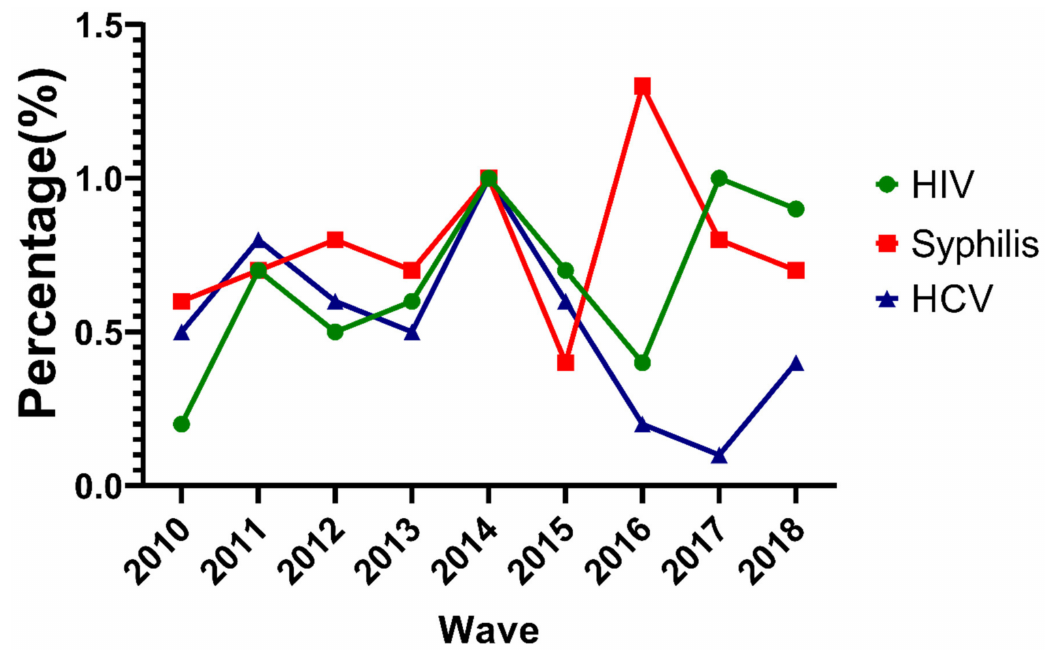
Figure 1. Trends of HIV, syphilis, and hepatitis C virus (HCV) prevalence for male migrant workers (MMWs) in Chongqing from 2010 to